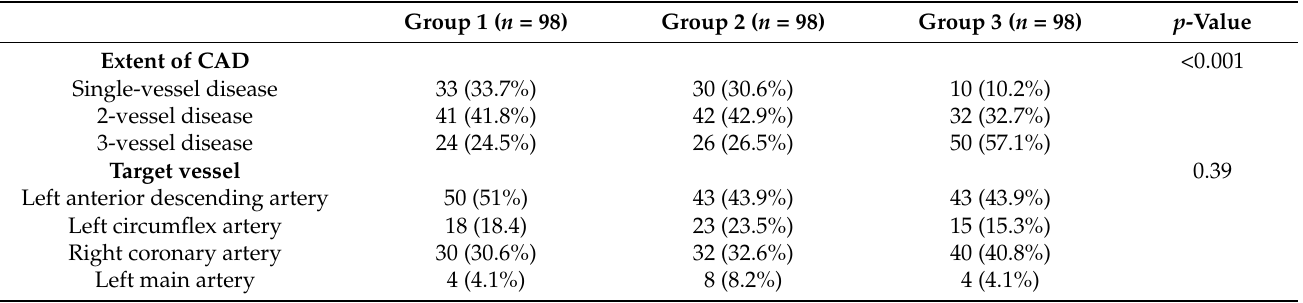
Table 2. Comparison of angiographic data of patients with acute myocardial infarction with different FT3/FT4 levels.